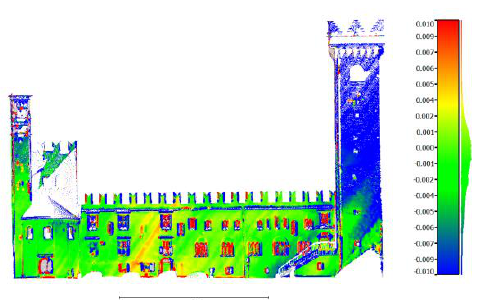
Figure 13. Colour-coded map of the comparison analysis between MMS and TLS data in the Garibaldi dataset. The scale ranges from – 0.01 m (blue) to 0.01 m